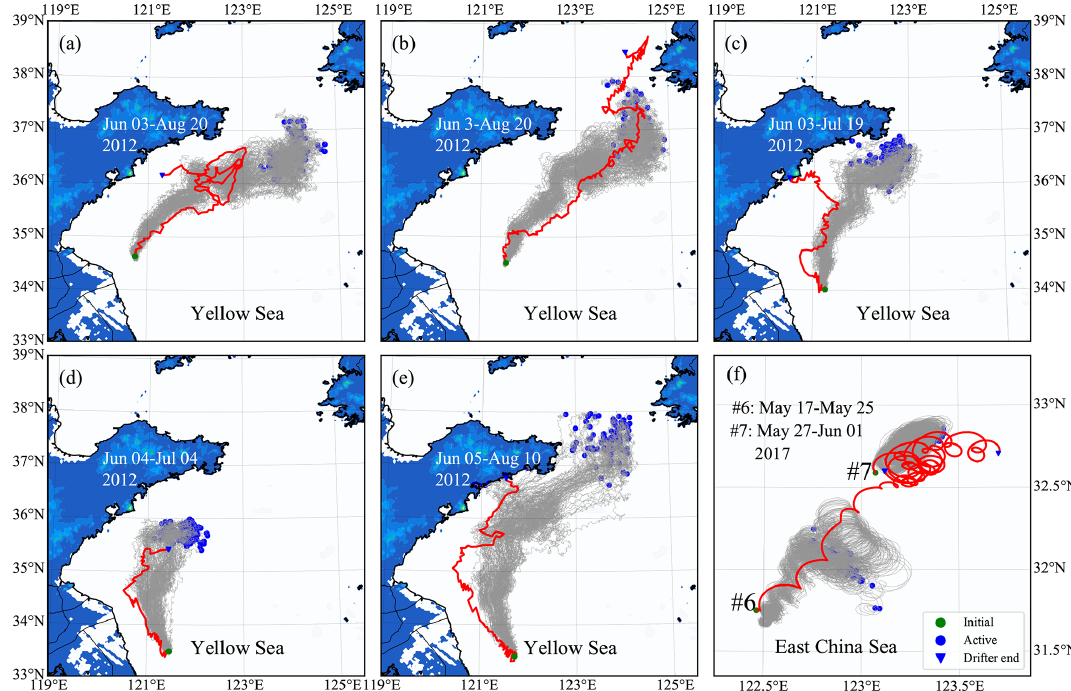
Figure 8. Comparisons between observed (red lines) and simulated (gray lines) drifter trajectories. Panels (a) – (e) correspond to the drifters nos. 1–5, respectively. Panel (f) corresponds to drifters nos. 6–7.